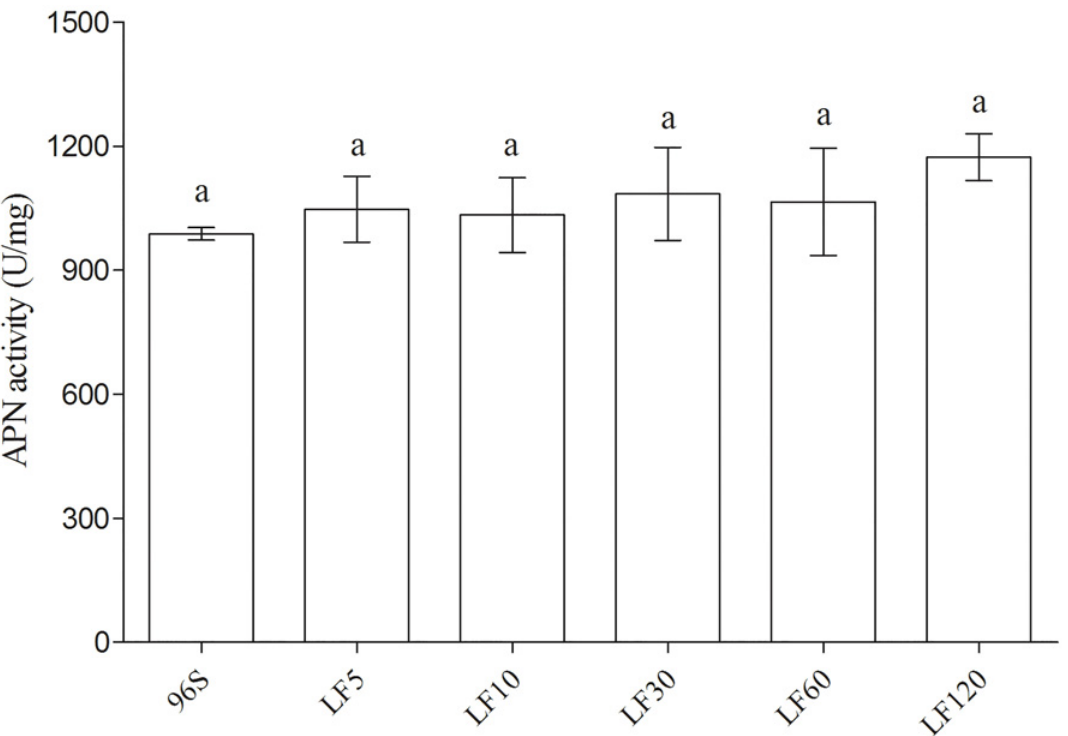
Fig 3. APN activity in BBMV from susceptible and resistant H . armigera larvae. The same letter (a) above the standard error bars indicates no significant differences in mean APN activity among strains (P > 0.05).